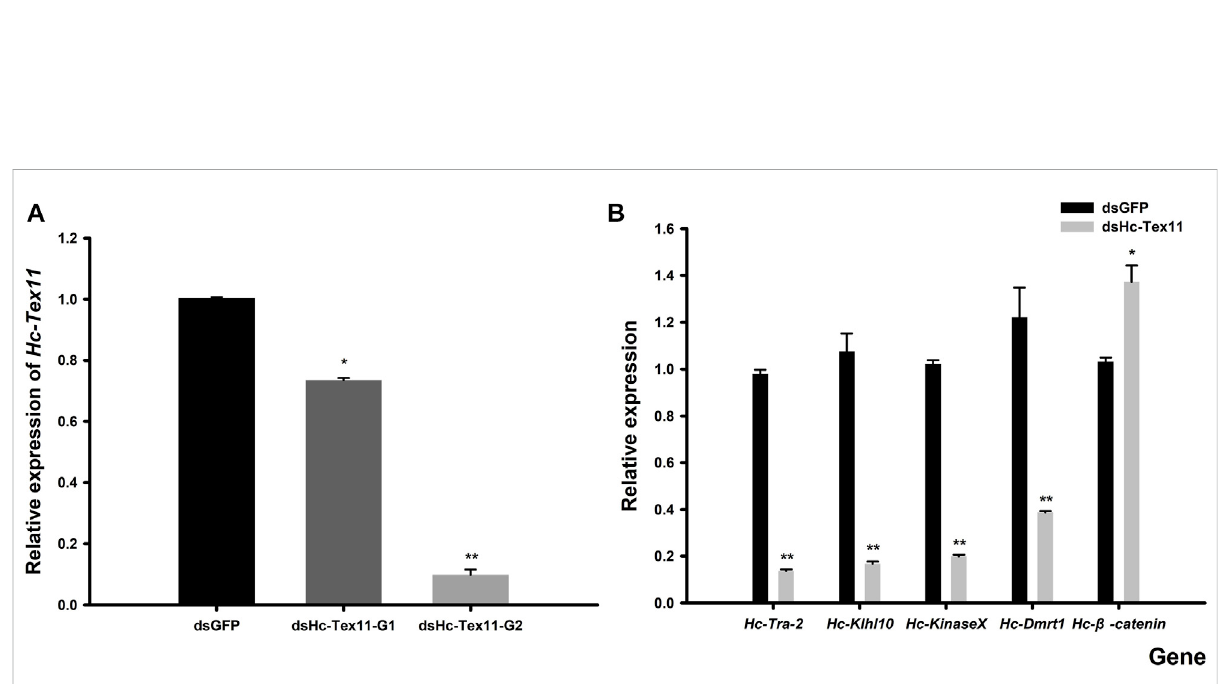
FIGURE 9 (A) Relative expression of Hc-Tex11 gene in male gonadal tissue after RNAi (B) Effect of dsHc-Tex11-2 injection on the expression of Hc-Tra-2, Hc-Klhl10, Hc-KinaseX and Hc-Dmrt1 and Hc- β -catenin genes in the testes of the H. cumingii . Control group, dsGFP; experimental group, dsHc-